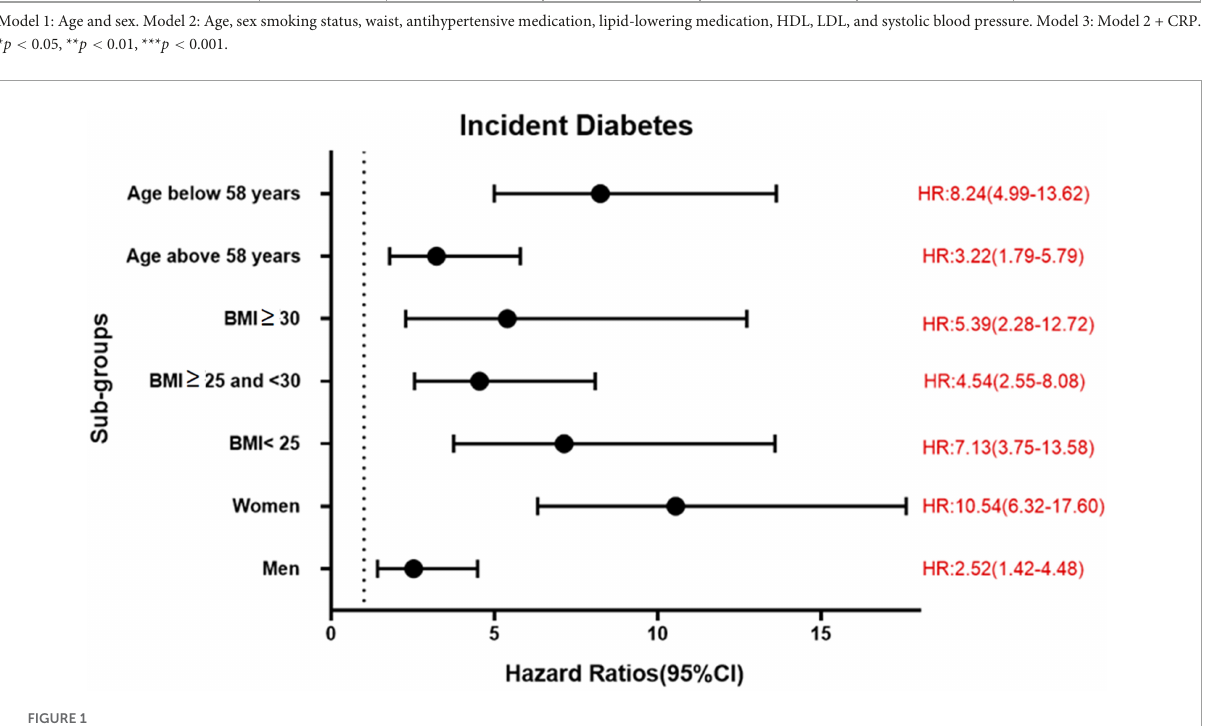
mortality, and only with BMI for cardiovascular